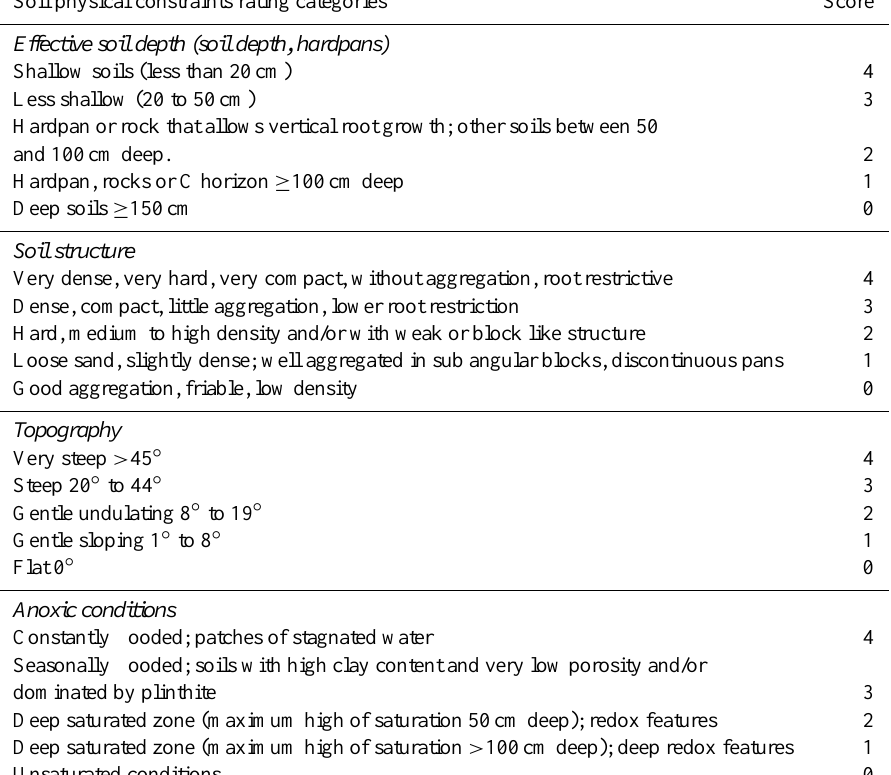
Deep saturated zone (maximum high of saturation > 100cm deep); deep redox features 1 Unsaturated conditions